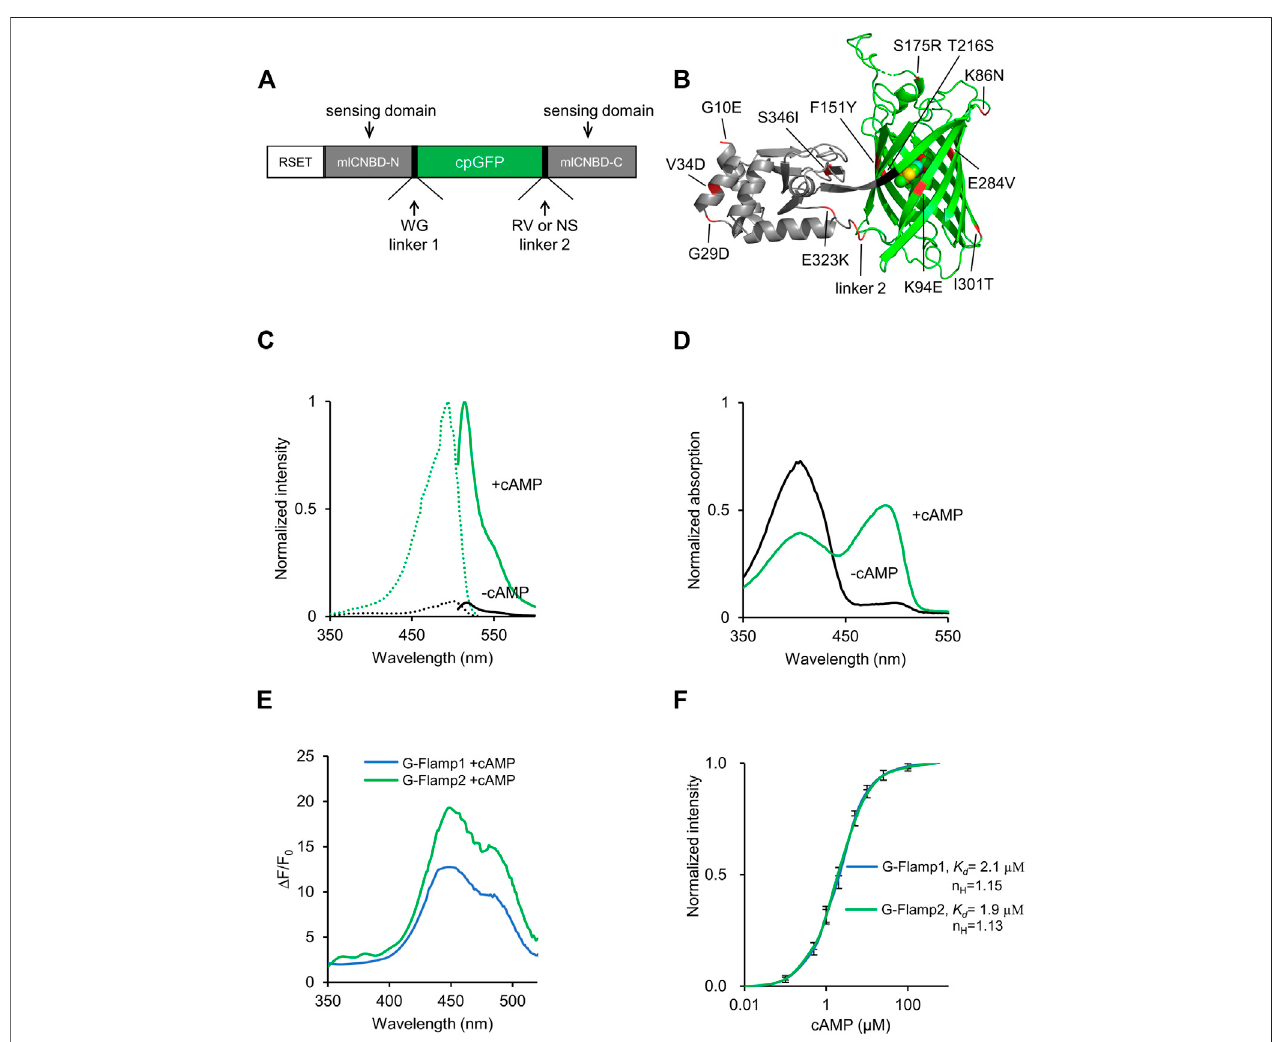
FIGURE1| Developmentand invitro characterizationofG-Flamp2. (A) SchematicofG-Flampbiosensor. cpGFPwasinsertedintomlCNBDwithlinker1andlinker 2 (both have two amino acids). RSET: the N-terminal fusion peptide including a 6× His tag from the pNCS bacterial expression vector. (B) Crystal structure of G-Flamp1 (PDB 6M63). Sites mutated in G-Flamp2 and G-Flamp2b are marked in red. Linker is marked in black. (C) Excitation (dotted lines) and emission (solid lines) spectra of puri fi ed G-Flamp2 sensor in HEPES buffer (pH 7.15) with (green line, +cAMP) or without (black line, -cAMP) 500 μ M cAMP. (D) Absorbance spectra of 50 μ M G- Flamp2 in HEPES buffer (pH 7.15) in the presence (green line, +cAMP) or absence (black line, -cAMP) of 500 μ M cAMP. (E) Excitation wavelength-dependent Δ F/F 0 of G-Flamp1 and G-Flamp2 in HEPES buffer (pH 7.15) in the presence of 500 μ M cAMP. (F) Binding titration curves of G-Flamp1 and G-Flamp2 biosensors to cAMP (500 μ M)inHEPESbuffer(pH7.15).Thedatawere fi ttedbyasigmoidalbindingfunctiontoextractthedissociationconstant K d .Dataarepresentedasmean±standard deviation (SD) from three independent experiments.